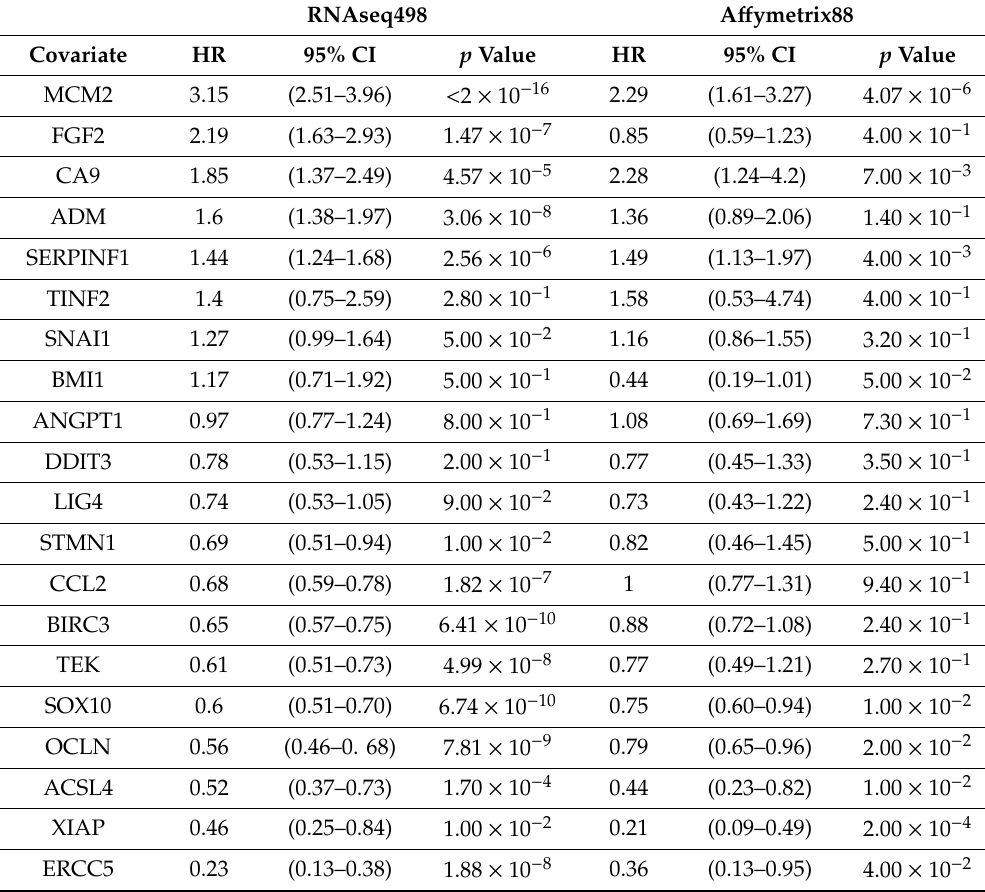
Table 1. Survival analysis correlating PTGs and PNGs to NB